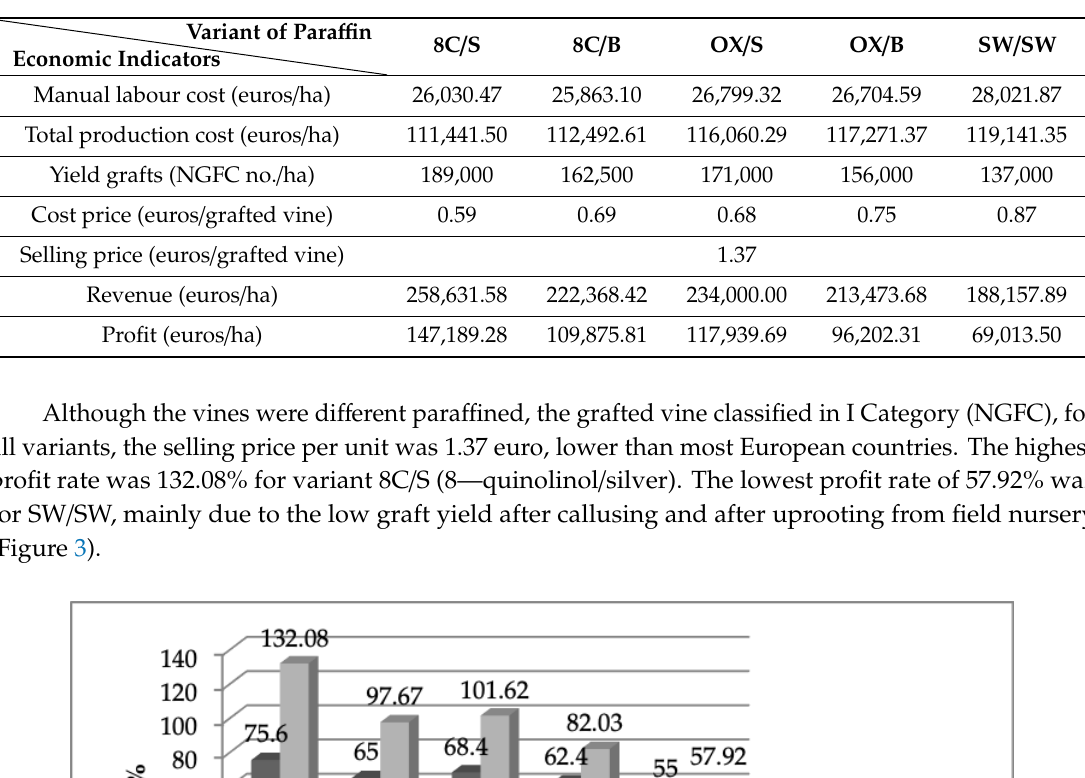
Table 5. Economic e ffi ciency indicators depending on para ffi ning variants at Muscat Ottonel variety, at Jidvei Company.